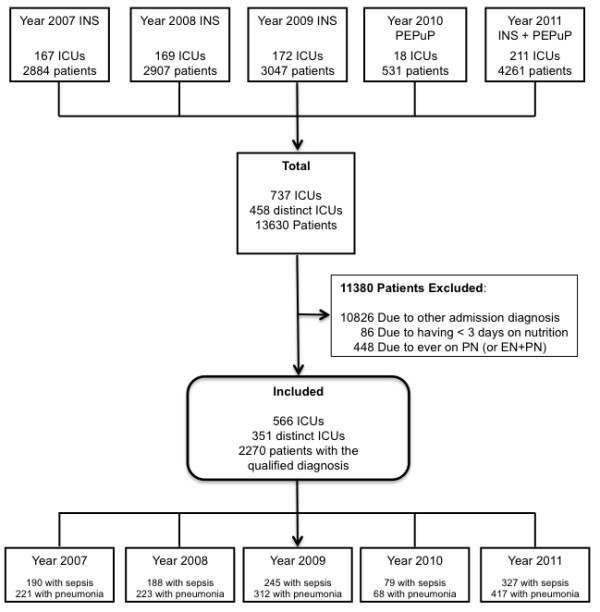
Flow chart of study population. Of 13,630 patients enrolled in the nutrition surveys and PEP uP trial between 2007 and 2011, 2,270 patients with pneumonia and sepsis from 351 ICUs were included in the final analysis. The 411 patients from the 2007 database were already included in a previous study [23]. EN, enteral nutrition; ICU, intensive care unit; INS, International Nutrition Survey; PN, parenteral nutrition.